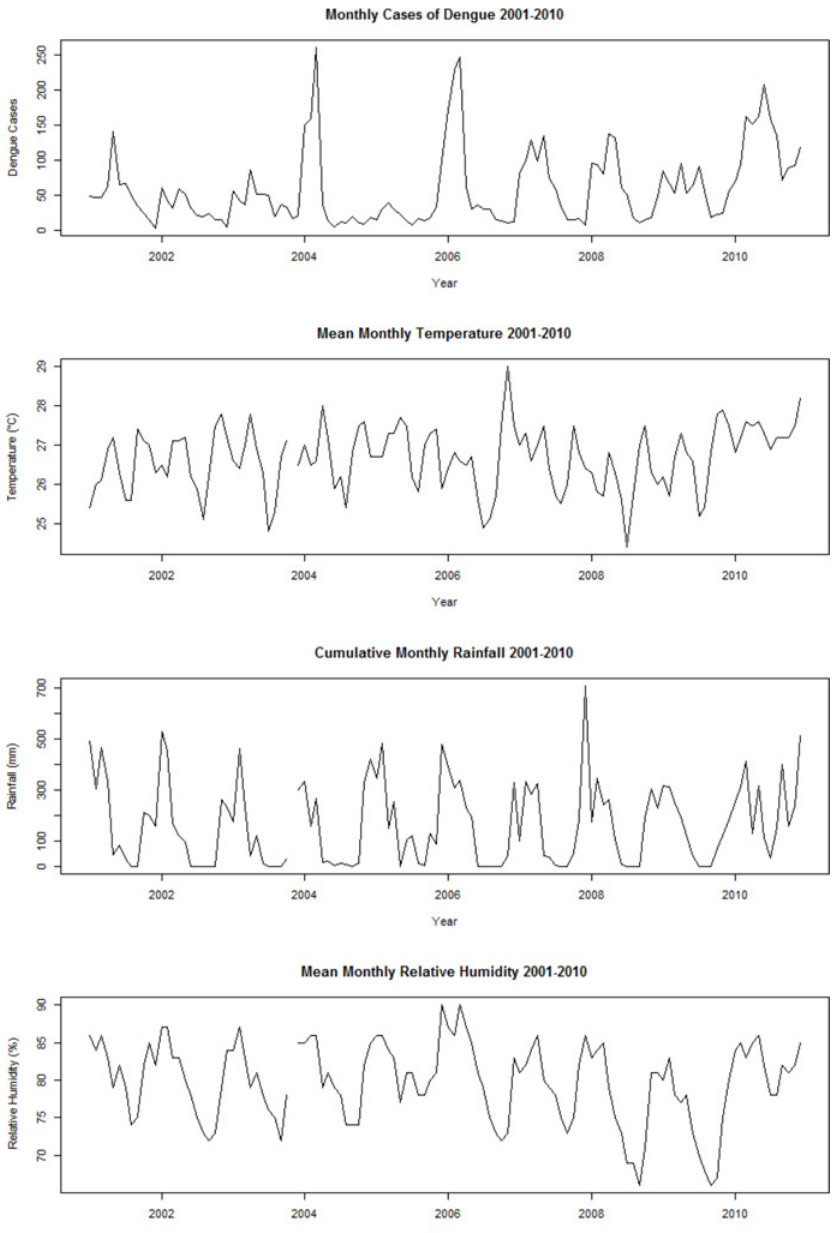
Fig 2. Time Series Graphs of Surveillance and Meteorological